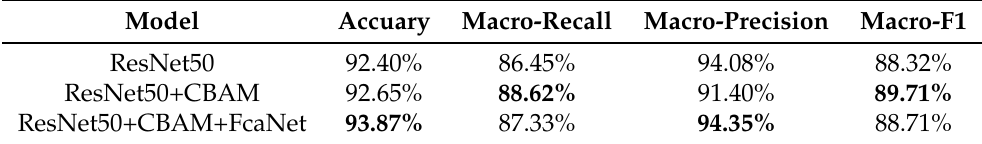
Table 2. The results of the ablation